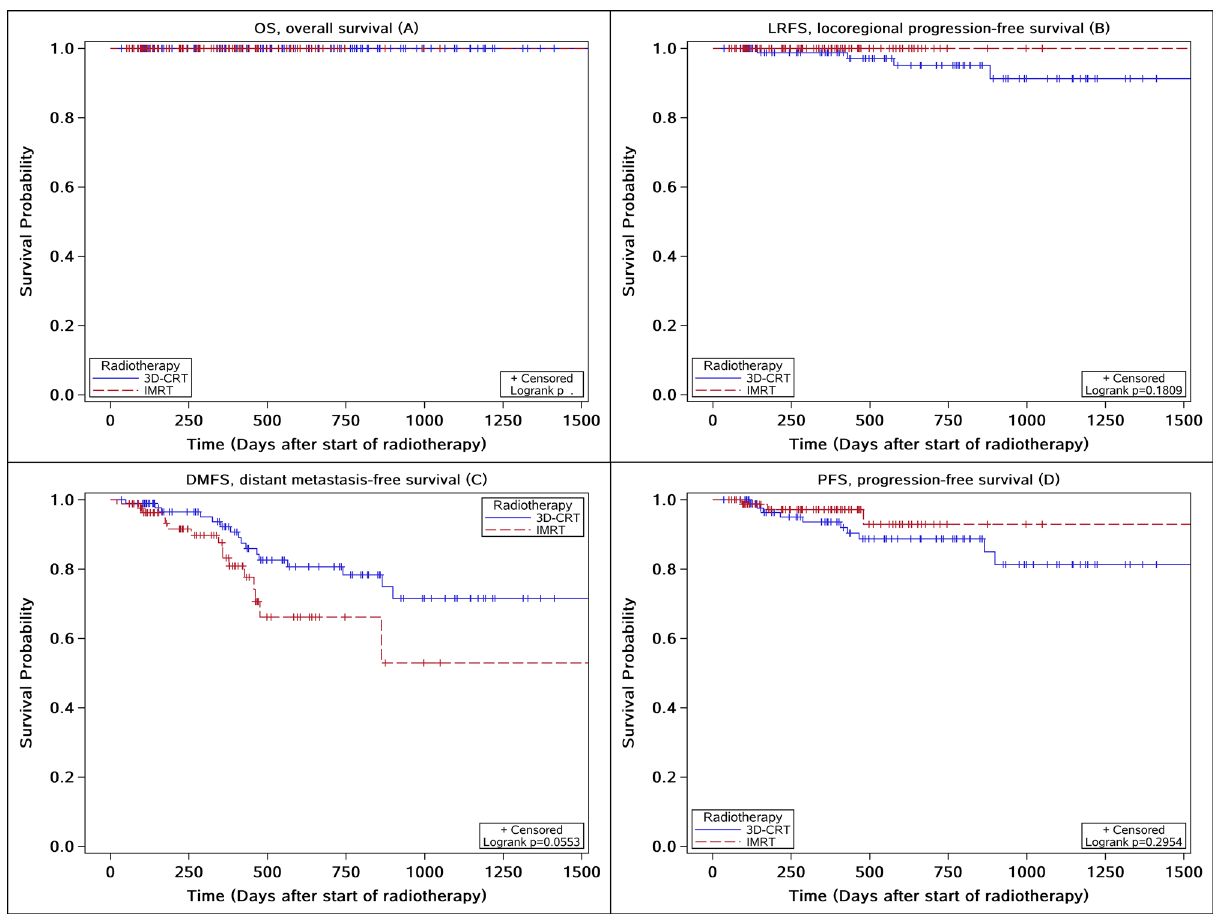
Figure 4. The survival curves of overall survival (OS) ( A ), locoregional progression-free survival (LRFS) ( B ), distant metastasis-free survival (DMFS) ( C ) and progression-free survival (PFS) ( D ) for NPC patients received IMRT versus